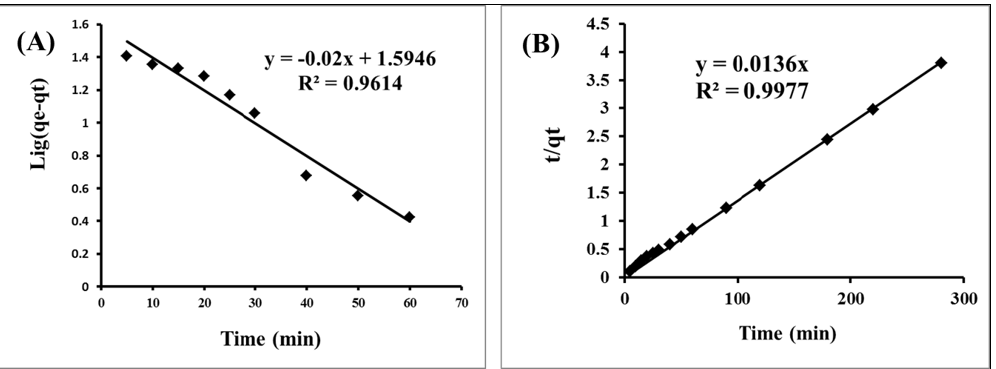
Figure 5. ( A ) Pseudo-first-order and ( B ) pseudo-second-order of the Hg(II) adsorption by IL-ACMRW (ionic liquid modified activated carbon from mixed recyclable waste), adsorbent dose 0.5 m/L, Hg(II) solution dose of 20 mg/L at pH